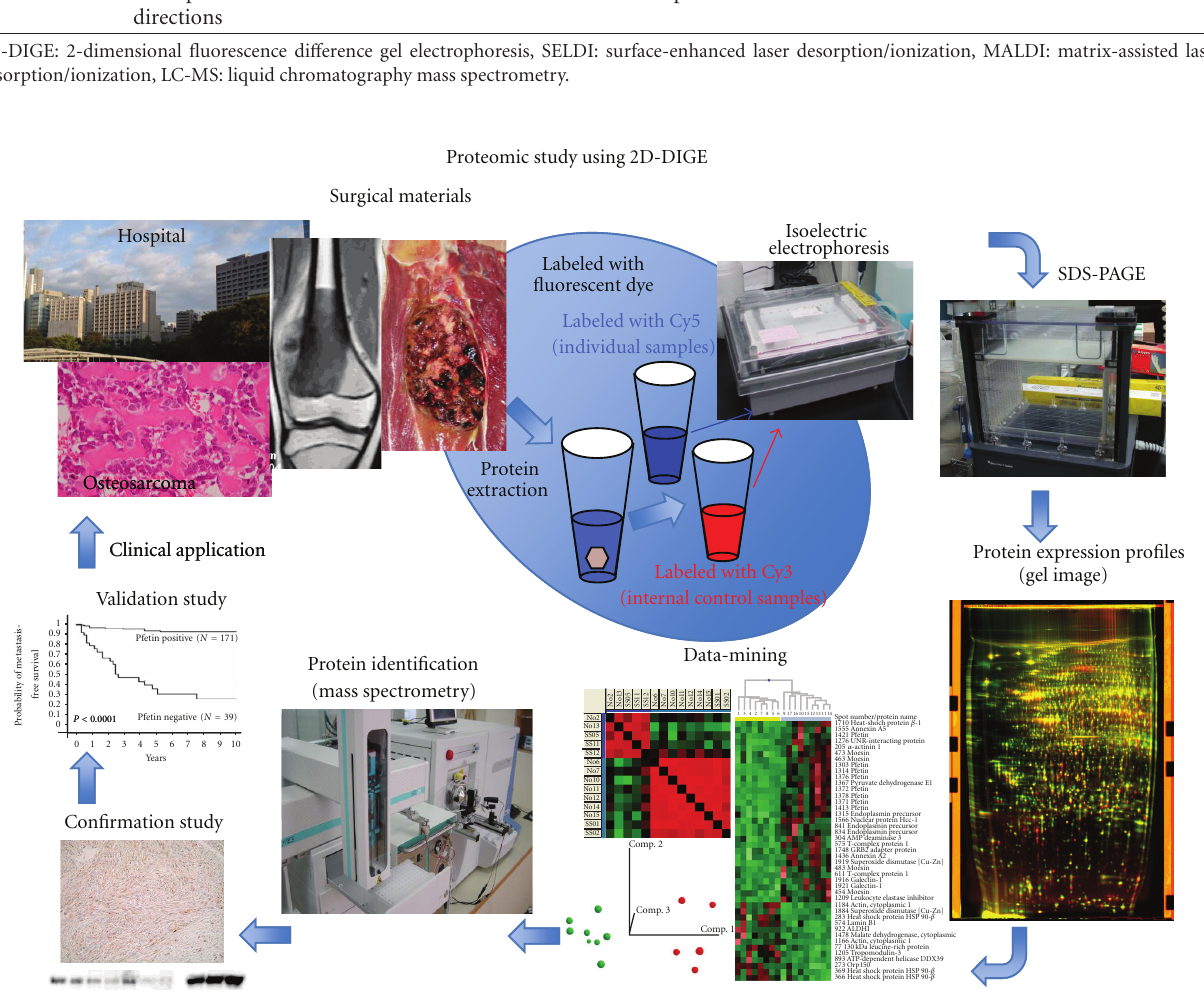
Figure 1: The process for 2D-DIGE-based target identification, confirmation, and validation. Surgical samples are collected from patients with osteosarcoma. Collected samples contain proteins associated with clinical information. All protein samples are labeled with di ff erent fluorescent dyes (The internal control sample is a mixture of a small portion of all individual samples labeled by Cy3, and the individual samples are labeled by Cy 5). The protein expression profiles are obtained using 2D-DIGE with highly sensitive fluorescent dyes. The protein expression profiles are analyzed to identify candidate biomarkers through data-mining using the proteomic profiles and clinical data. The protein expression levels are then confirmed by a western blot analysis and/or immunohistochemistry. The biomarker candidates are validated using additional large-variation cohorts to develop them for clinical